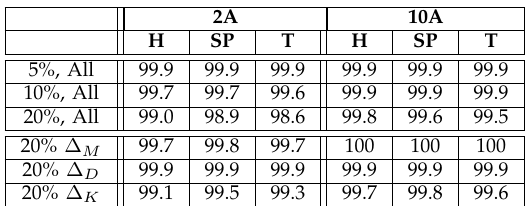
Fig. 18: Gain tunings for 20% uncertainty in the damp- ing term for sea-state 2A. TABLE III: Median electrical power capture for intro- duced modeling error for sea-state 2A and 10A in heave (H), coupled surge and pitch (SP), and the total